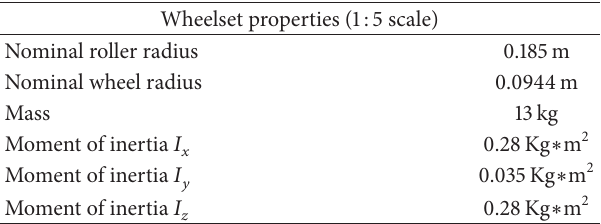
Table 1: Wheelset geometrical and inertial